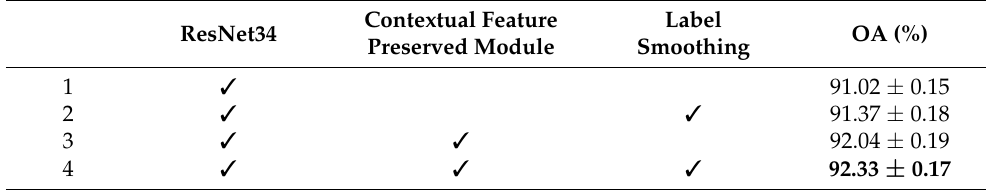
Table 5. Overall accuracy (%) of HCFPN using different components when trained on the WH-MAVS dataset using a proportion of 10% of the samples.